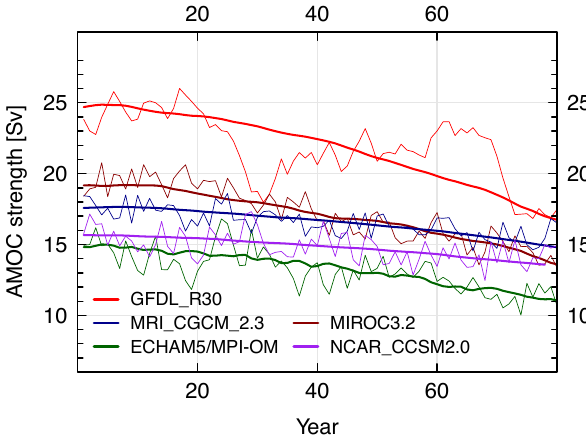
Fig. 3. Comparison of the calibrated model outcome (thick line) with the AOGCM reference data for the 1% CO 2 increase scenario from Gregory et al. (2005) (thin line). Our emulation outcome re- produces the weakening trend of all five AOGCMs.